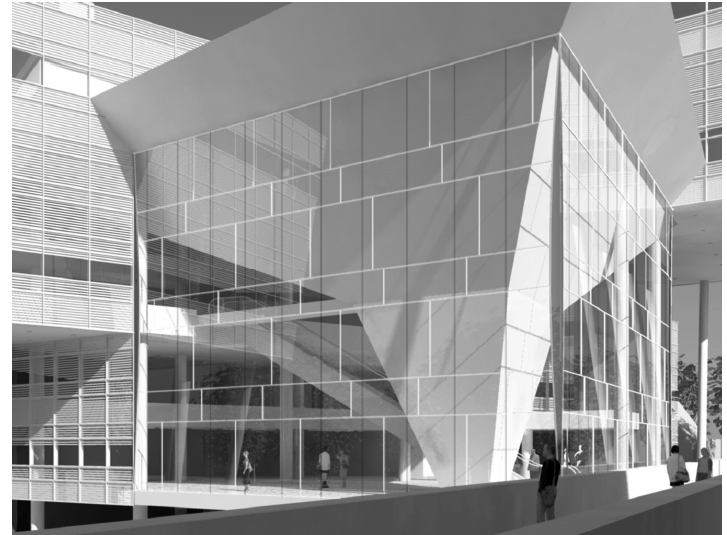
Figure 12: Impression of the living composite glass facade (image Rietveld